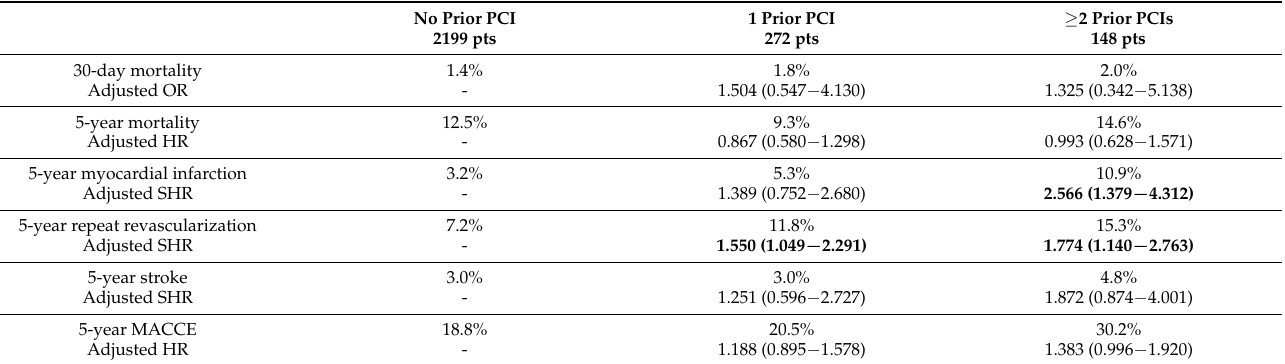
Table 2. Crude rates and adjusted risk estimates of outcomes in the study